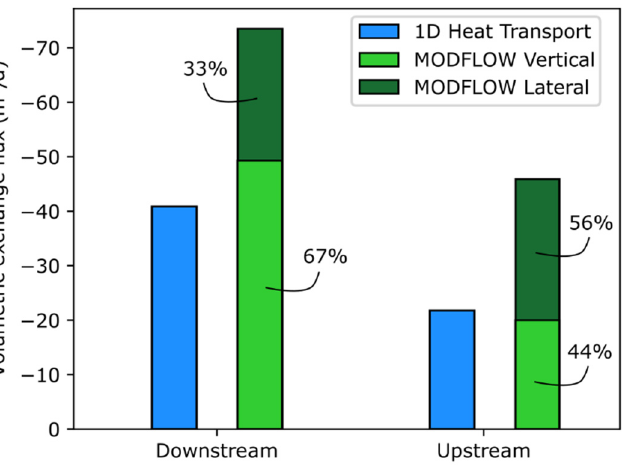
Figure 13. Comparison of volumetric exchange flux estimated based on the 1D analytical solution (blue) and the groundwater flow model (green) for the downstream and upstream sections.